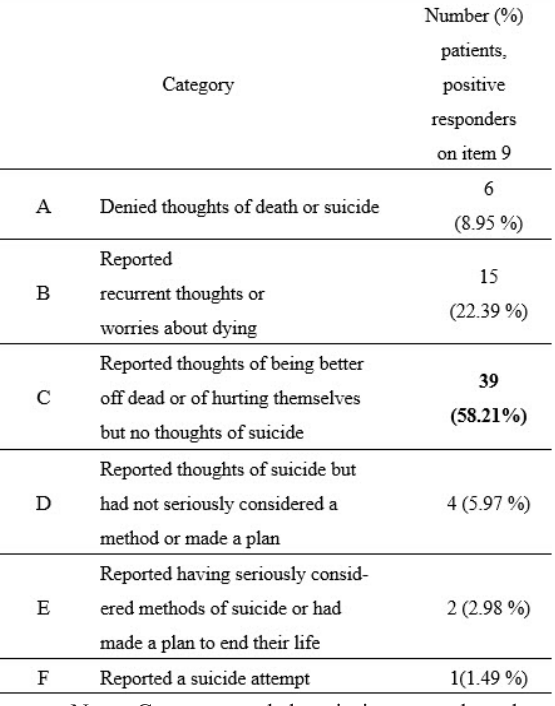
Thoughts of Death and Suicide over preced- ing 4 weeks as elicited at interview and the number (%) of patients reporting each.